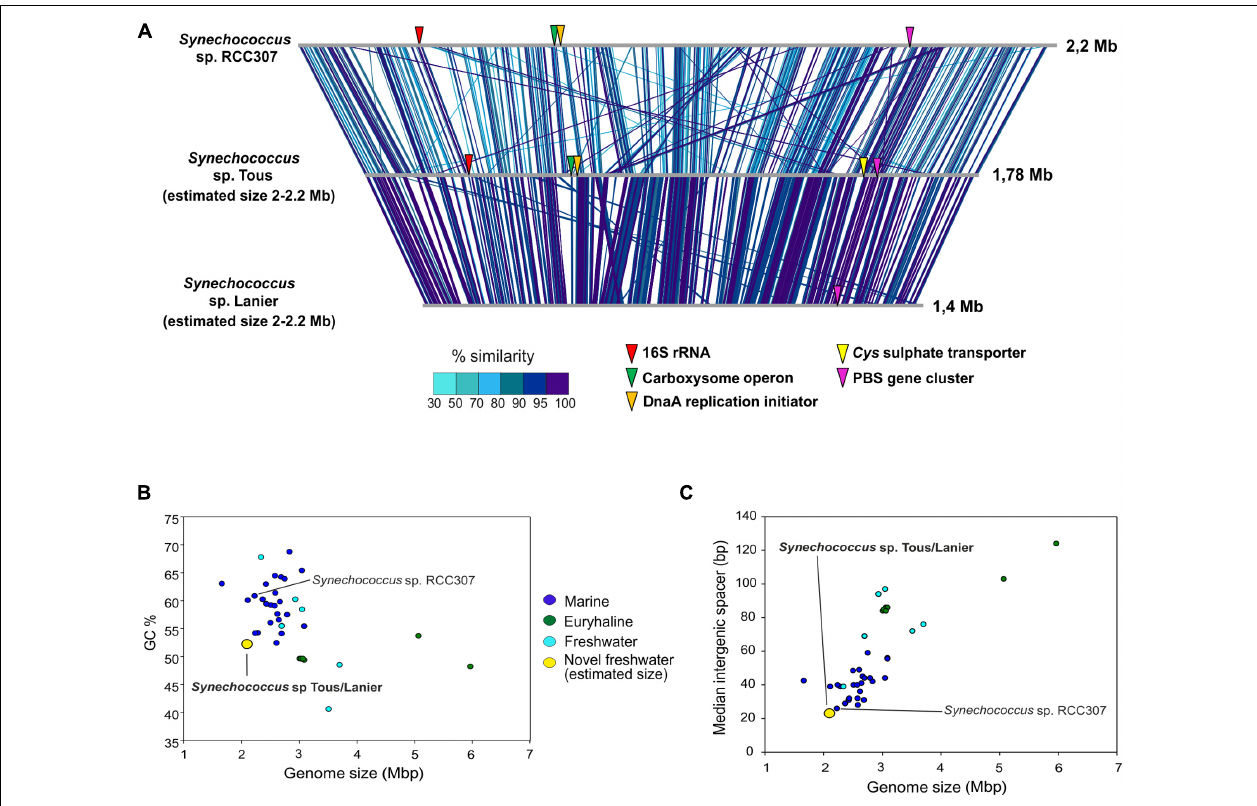
FIGURE 2 | (A) Genomic comparison between marine Synechococcus sp. RCC307 and the novel freshwater assembled genomes from Tous and Lanier. Comparison made with BLASTN with 50 bp alignment length and > 70% similarity. 16S rRNA, DnaA replication initiator, carboxysome operon, Cys sulfate transporter and PBS genes are indicated in the genomes. (B) Genome size (Mbp) vs. GC content of all marine, freshwater and euryhaline Synechococcus sp. sequenced genomes. (C) Genome size (Mbp) vs. median intergenic spacer (bp) of all Synechococcus sp. genomes. Estimated genome size was used for the novel freshwater Synechococcus